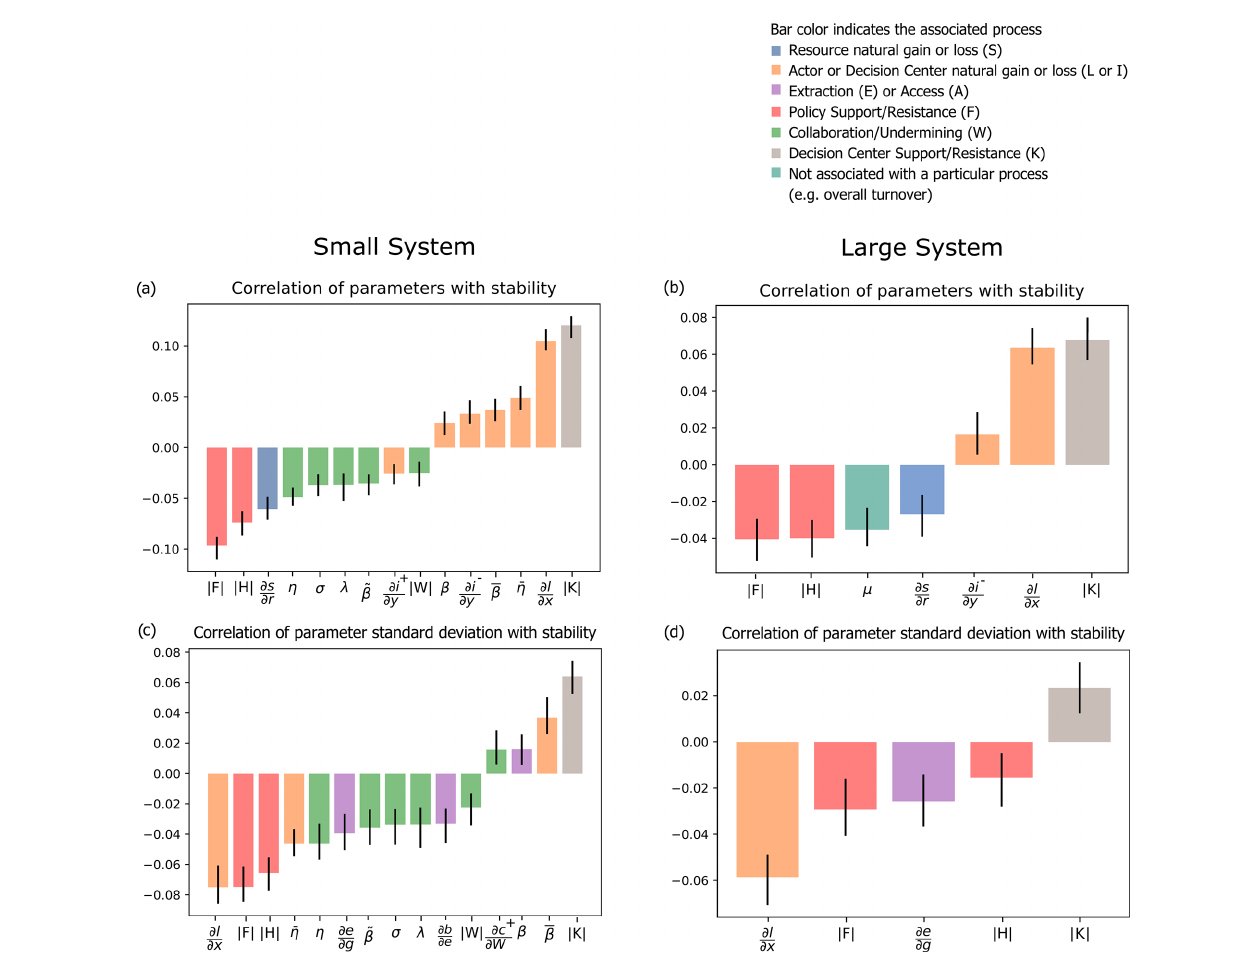
Figure 2. Correlation of mean (a, b) and standard deviation (c, d) of parameters with stability in small (a, c) and large (b, d) systems. Only parameters with a statistically significant effect on stability and with a correlation greater than 0.01 are shown. Stabilizing factors include the proportion of effort put into influencing the capacity of decision centers ( | K | ), sensitivity of attrition to the current organizational capacity ( ∂l/∂x ), the share of loss in capacity due to attrition ( η ), share of gain in capacity from organization self-growth efforts ( β ), the sensitivity of decision center loss in capacity to their capacity ( ∂i/∂y n ), and the gain in capacity motivated by resource access conditions ( β ). Destabilizing factors consist of the proportion of effort put into spent on influencing effectiveness of policies ( | F | and | H | ) and on collaborating or undermining ( | W | ), the sensitivity of resource regeneration to the resource state ( ∂s/∂r ), share of loss in capacity from undermining by other actors ( η and λ ), share of gain from collaboration ( (cid:101) β and σ ), and the sensitivity of decision center growth in capacity to their own capacity ( ∂i / ∂y p ) . The standard deviation results reveal that in addition to these parameters, variation in the sensitivity of extraction to the intervention ( ∂e/∂g ) and the sensitivity of gain in capacity to the ability to extract ( ∂b/∂e ) is